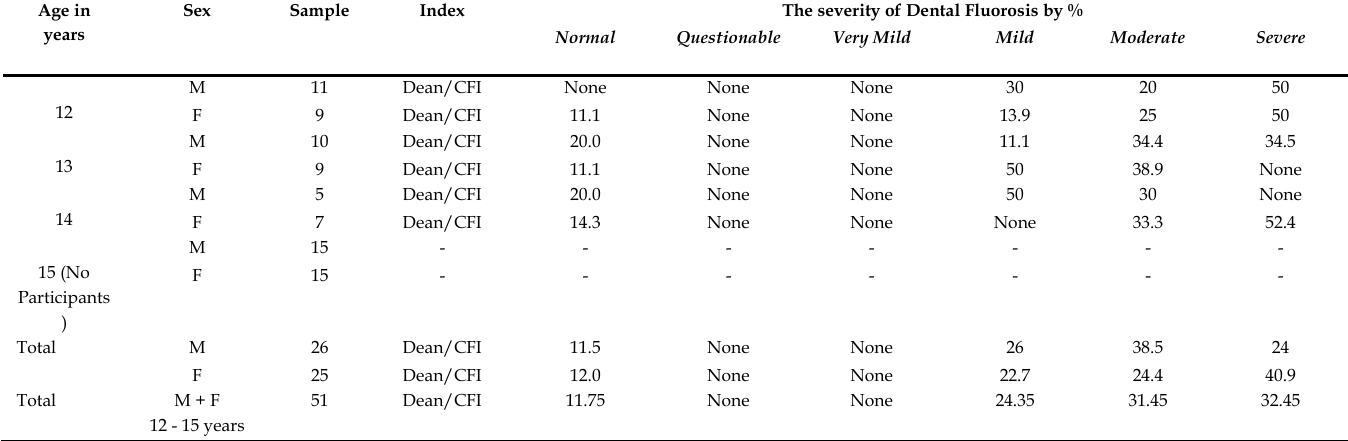
Table 3: The severity of dental fluorosis in Semi-urban studied population Age in Sex Sample years